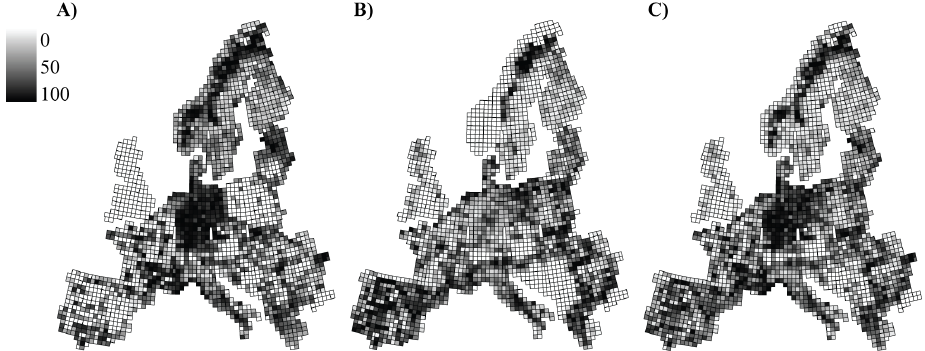
Figure 1 Figure 1. Proportions of protected areas included in the World Database on Protected Areas (A) , the NATURA 2000 network (B) and both